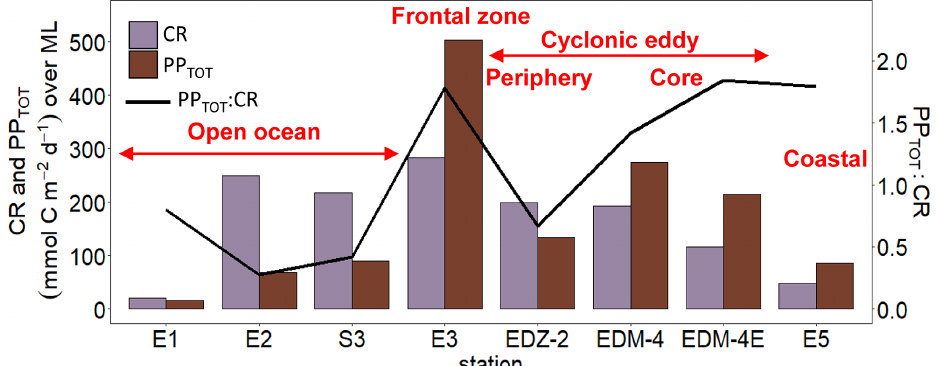
Figure 6. Integrated total primary production (PP TOT ) and community respiration (CR) rates over the mixed layer during